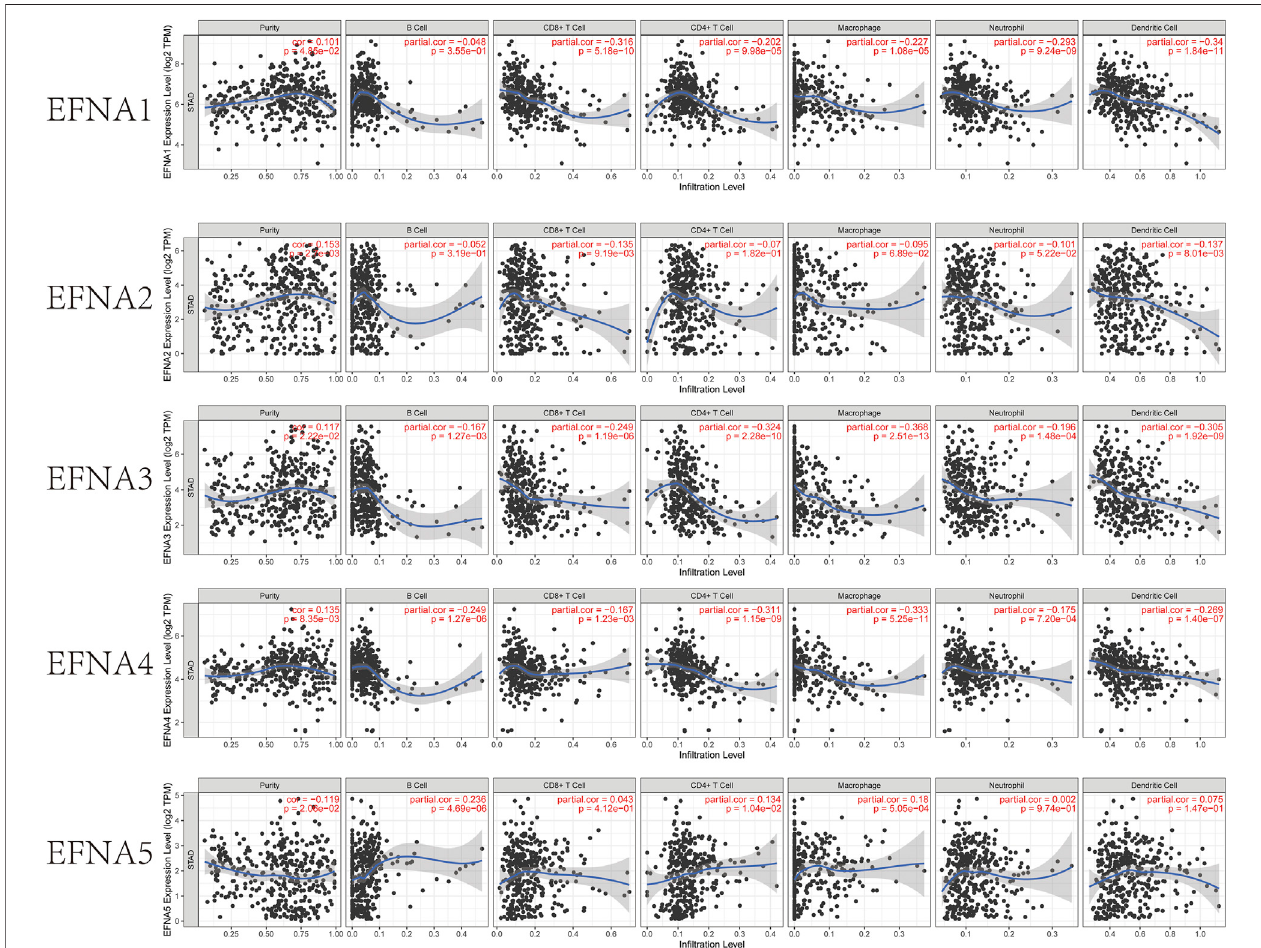
FIGURE 5 | TIMER estimation of the immune in fi ltration level associated with EFNA1 – 5 genes. The in fi ltrating immune cells include B cells, CD8 + T cells, CD4 + T cells, M2 macrophages, neutrophils, and dendritic cells. Correlation between EFNA1-5 with the abundance of various immune cells in gastric cancer.